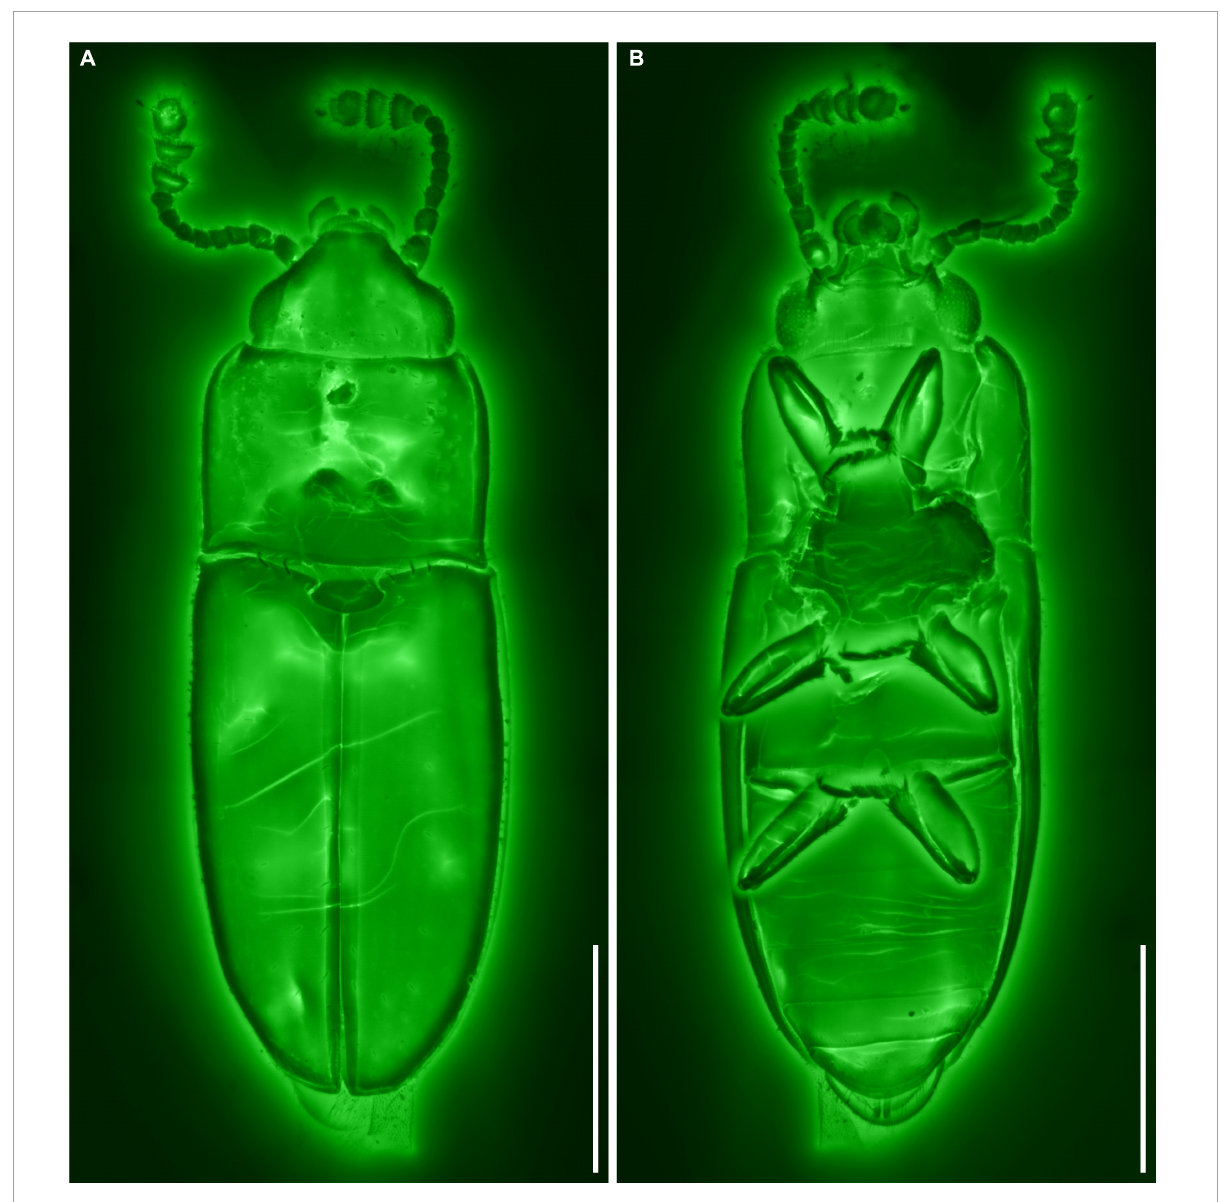
FIGURE2 General habitus of Alloterocucus atratus Li, Leschen Liu, and Cai gen. et sp. nov., holotype, NIGP180056, under confocal microscopy. (A) Dorsal view. (B) Ventral view. Scale bars: 400 µ m.